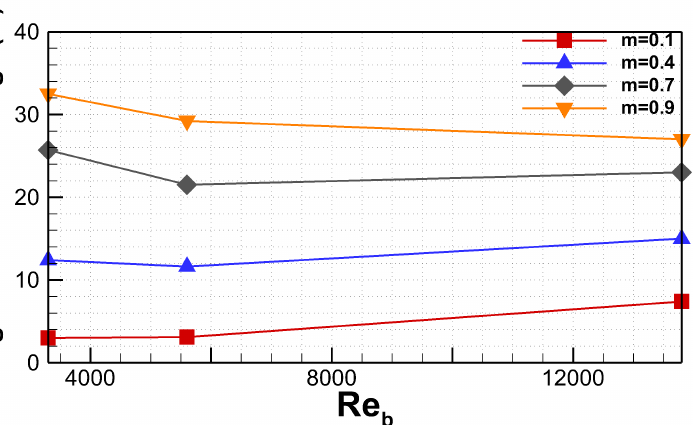
Figure 2. Drag increase percentage values ( D %) for: Re = 3300,5600 and 13,800 of the present: m = 0,0.1,0.4 and 0.9